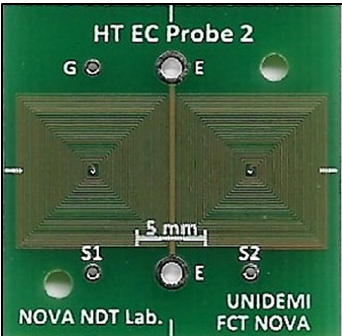
Figure 11. PCB probe developed for the inspection of the pipe base material. Linear excitation element cantered within the two differential coils.